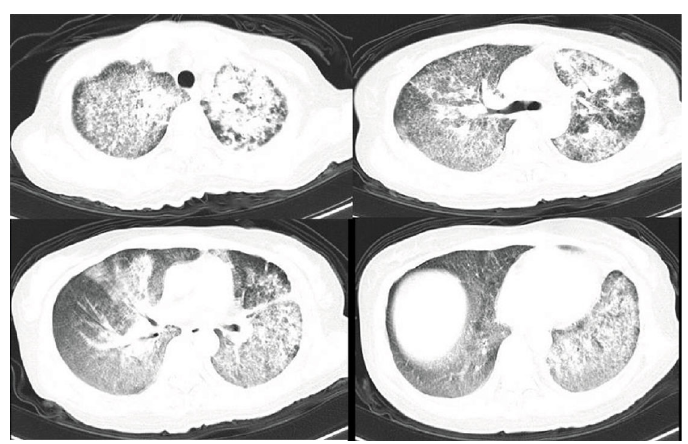
Figure 1: Characteristics of chest CT scan changes in